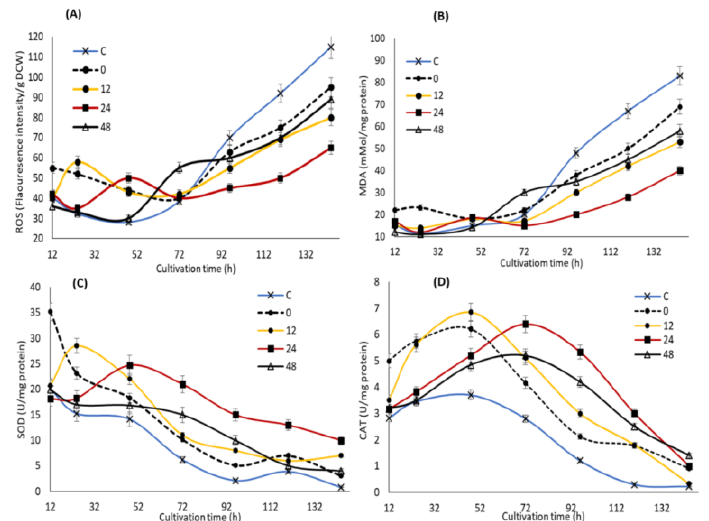
Figure 4. The impact of the synergistic optimal concentration of KIN, JA and GA on ROS ( A ), MDA ( B ), SOD ( C ) and CAT ( D ) at the 0, 12, 24 and 48 h feeding points in SW1. Values and error bars represent the means and the standard deviations of triplicate experiments ( n = 3).